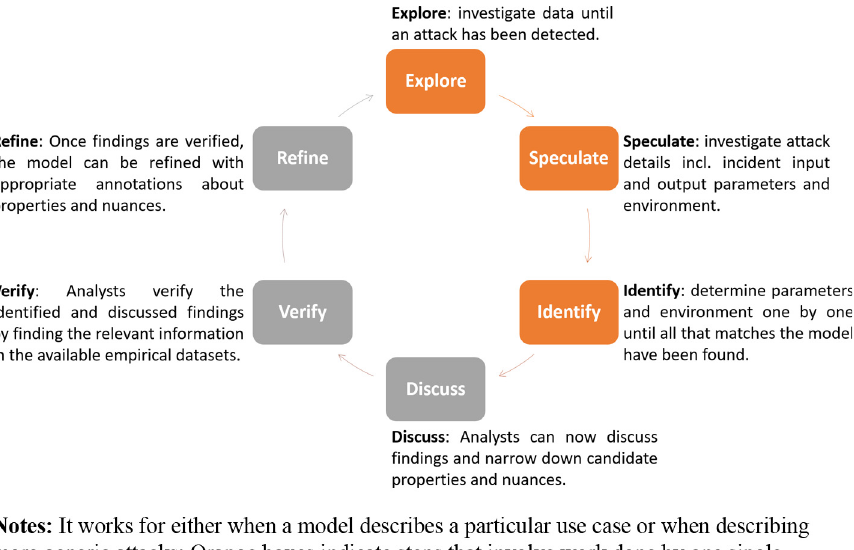
Figure 1. The feedback look of using an attack model to understand an